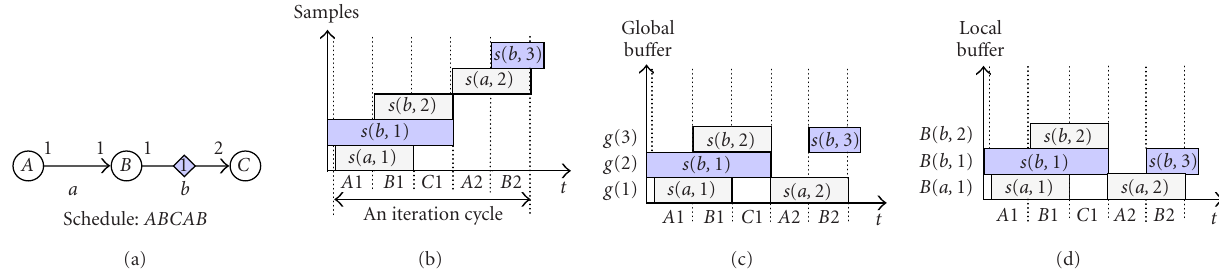
Figure 4: (a) An example of SDF graph with an initial delay between B and C illustrated by a diamond, (b) the sample lifetime chart, (c) a global bu ff er lifetime chart, and (d) a local bu ff er lifetime